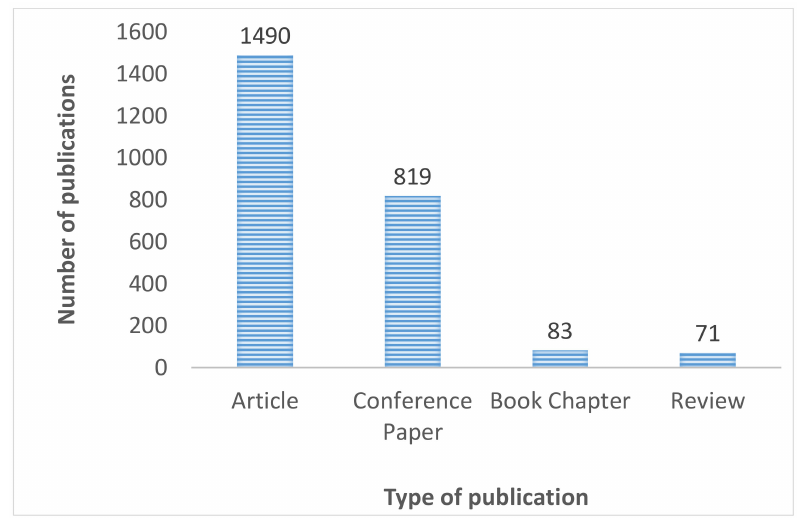
Figure 6. Type of publication of paper published until September 2022.